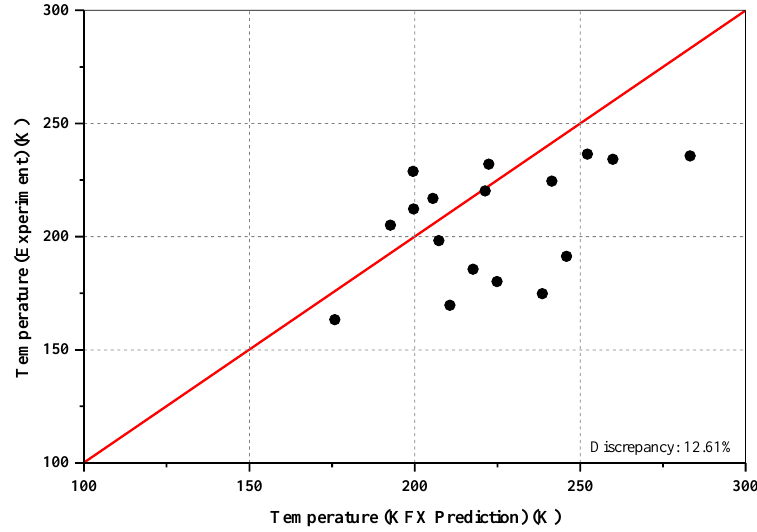
Figure 10. Plot of test temperature and KFX prediction.